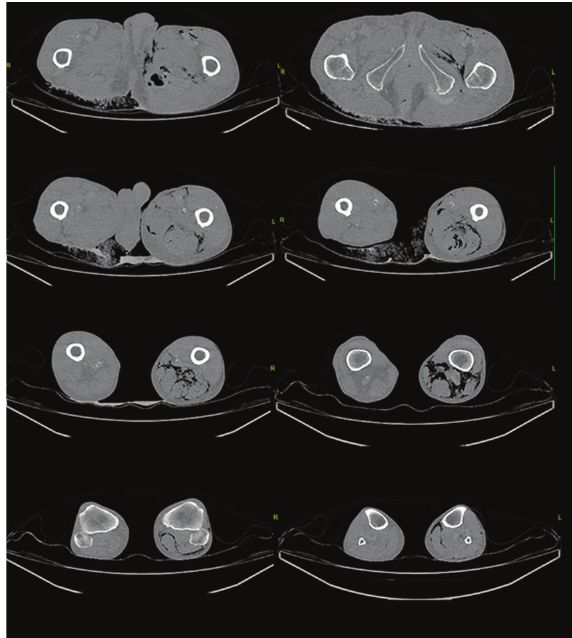
Figure 2: Axial CT scan of the lower leg starting from the hip to the knee with sharply demarcated free air in the soft